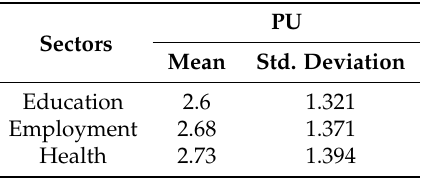
Table 7. Ranking of information sectors.